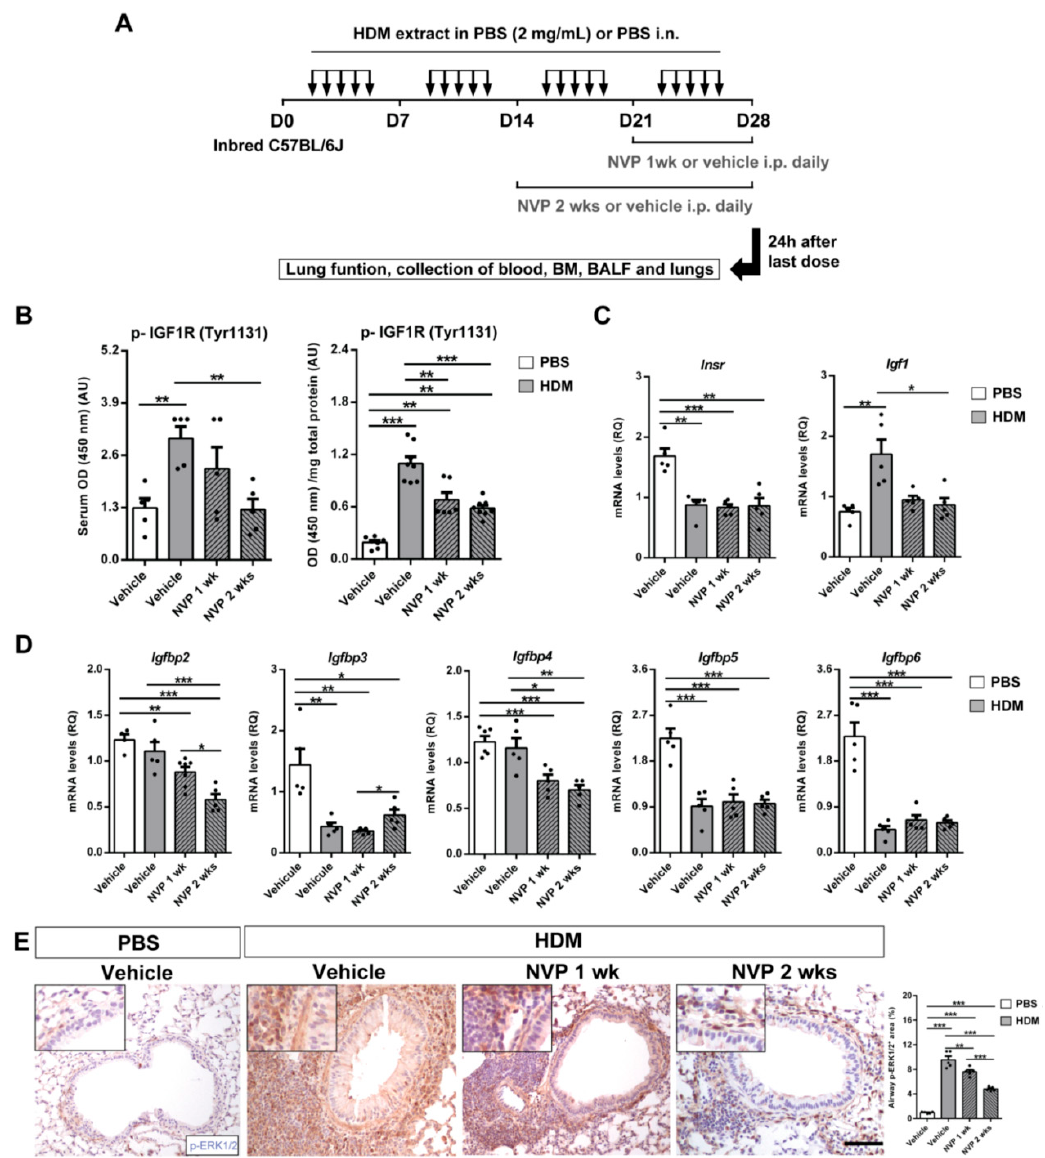
Figure 1. Protocol for HDM exposure and treatment with the IGF1R inhibitor NVP, as well as p-IGF1R and IGF system gene expression levels in the lung. ( A ) Mice were challenged by intranasal (i.n.) administration of HDM extract in phosphate buffer saline (PBS) or equal volume of vehicle, five days a week for four weeks. Mice also received intraperitoneal (i.p.) injections of the IGF1R inhibitor NVP or equal volume of the vehicle (2% DMSO) twice daily during the last one (NVP 1 week) or two weeks (NVP 2 weeks) of the HDM protocol. Lung function assessment and collection of blood, bone marrow (BM), BALF and lungs were performed 24 h after the last exposure on day ( D ) 28. ( B ) p-IGF1R protein levels in both serum and lung homogenates from HDM-challenged mice treated with NVP vs. controls ( n = 6–8 mice per group). ( C , D ) Lung tissue mRNA expression of IGF system-related genes Insr , Igf1 ( C ), and Igfbp2, Igfbp3, Igfbp4, Igfbp5, Igfbp6 ( D ) normalized to 18S expression in HDM-challenged mice treated with NVP vs. controls ( n = 5 mice per group). ( E ) Representative immunostains of proximal airways for p-ERK1/2 (p-42/44) (brown), and quantification of p-ERK1/2 + area (%) in lung sections from HDM-challenged mice treated with NVP vs. controls ( n = 5 mice per group; scale bar: 50 μ m). Insets illustrate p-ERK1/2 expression in smooth muscle cells and peribronchiolar areas. Data are expressed as mean ± SEM. * p < 0.05; ** p < 0.01; *** p < 0.001 (Mann–Whitney U test or Student´s t -test for comparing two groups, and Kruskal–Wallis test or ANOVA multiple comparison test for grouped or multivariate analysis).